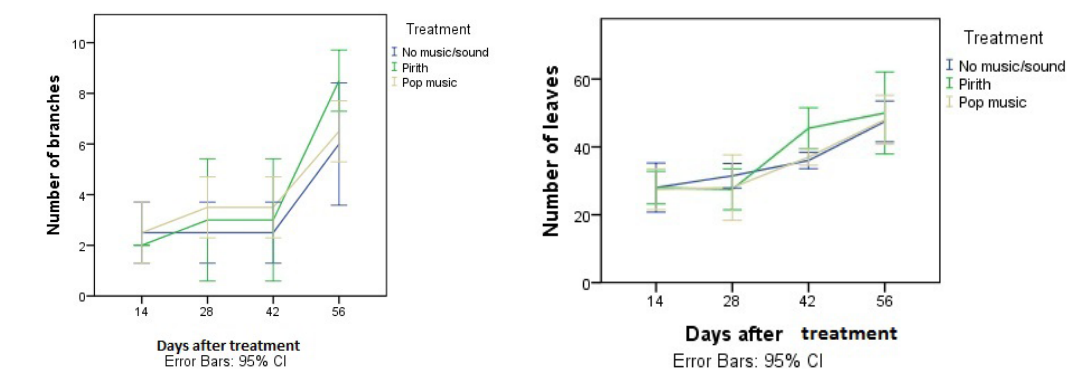
Figure 4: Effect of sound treatments on (a) number of branches and (b) number of leaves.